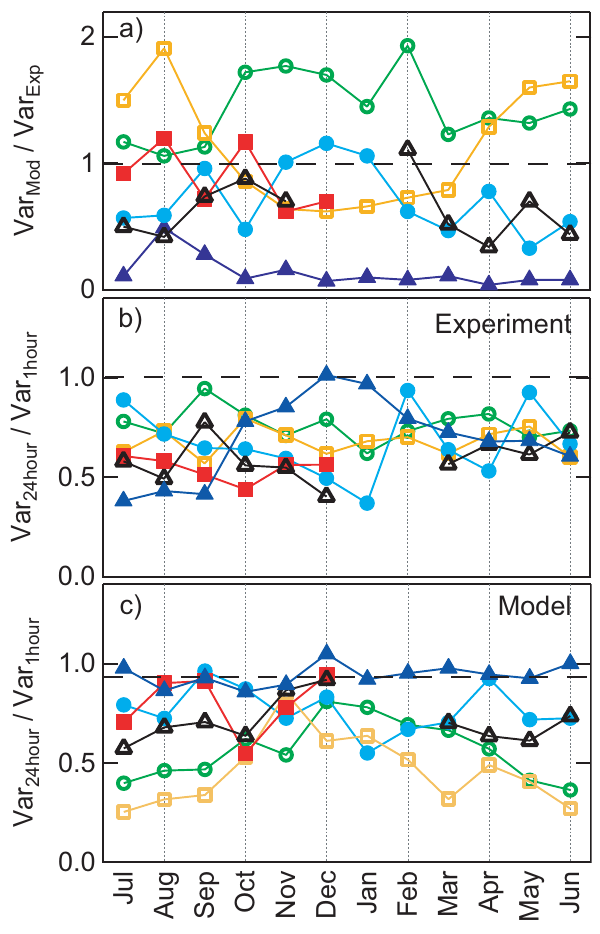
Fig. 5. Panel (a) : explained variability, defined as ratio of model variability to experiment variability, from July 2002 to June 2003, at Alert (blue triangle), Bondville (green open circles), Ispra (yellow open squares), Jungfraujoch (light blue circles), Mace Head (red squares), and Trinidad Head (black triangles). Panel (b) and (c) : variability ratio of 24-hour resolution data to 1-hour resolution data for experiment (b) and model (c).